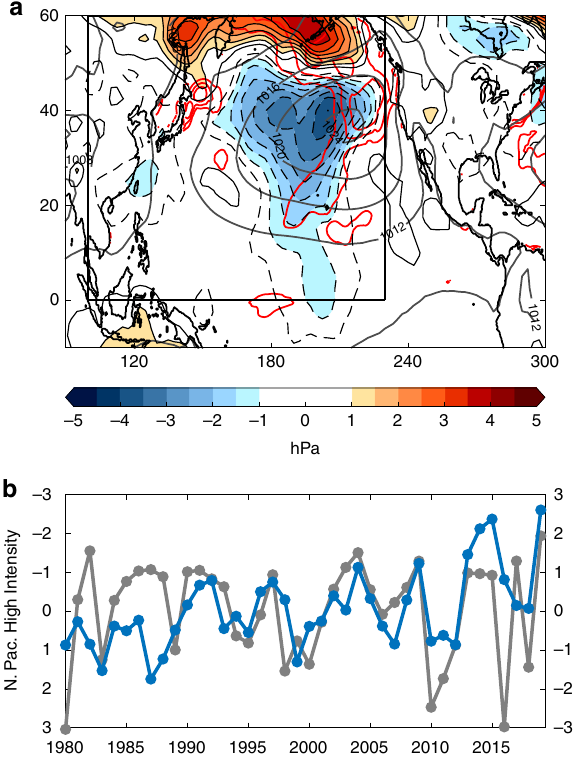
Fig. 2 Atmospheric circulation anomalies during summer 2019. a Detrended sea level pressure anomalies (SLPAs; hPa; shading) from atmospheric reanalysis averaged June – August (JJA) 2019 (shading and thin contours). Heavy dark contours represent JJA SLP climatology. Red contours are sea surface temperature anomalies (SSTAs) from Fig. 1a (starting at 1 °C with 0.5 °C interval). Black box represents area of comparison for Best Member results in Fig. 5d – f. b Time series of the North Paci fi c High Intensity index (gray/left y -axis; hPa; negative = weaker; see “ Methods ” ) and normalized JJA SSTA area-weighted averaged in the black box shown in Fig. 1a (blue/right y -axis) for the period 1980 – 2019. Note the inverted left y -axis.